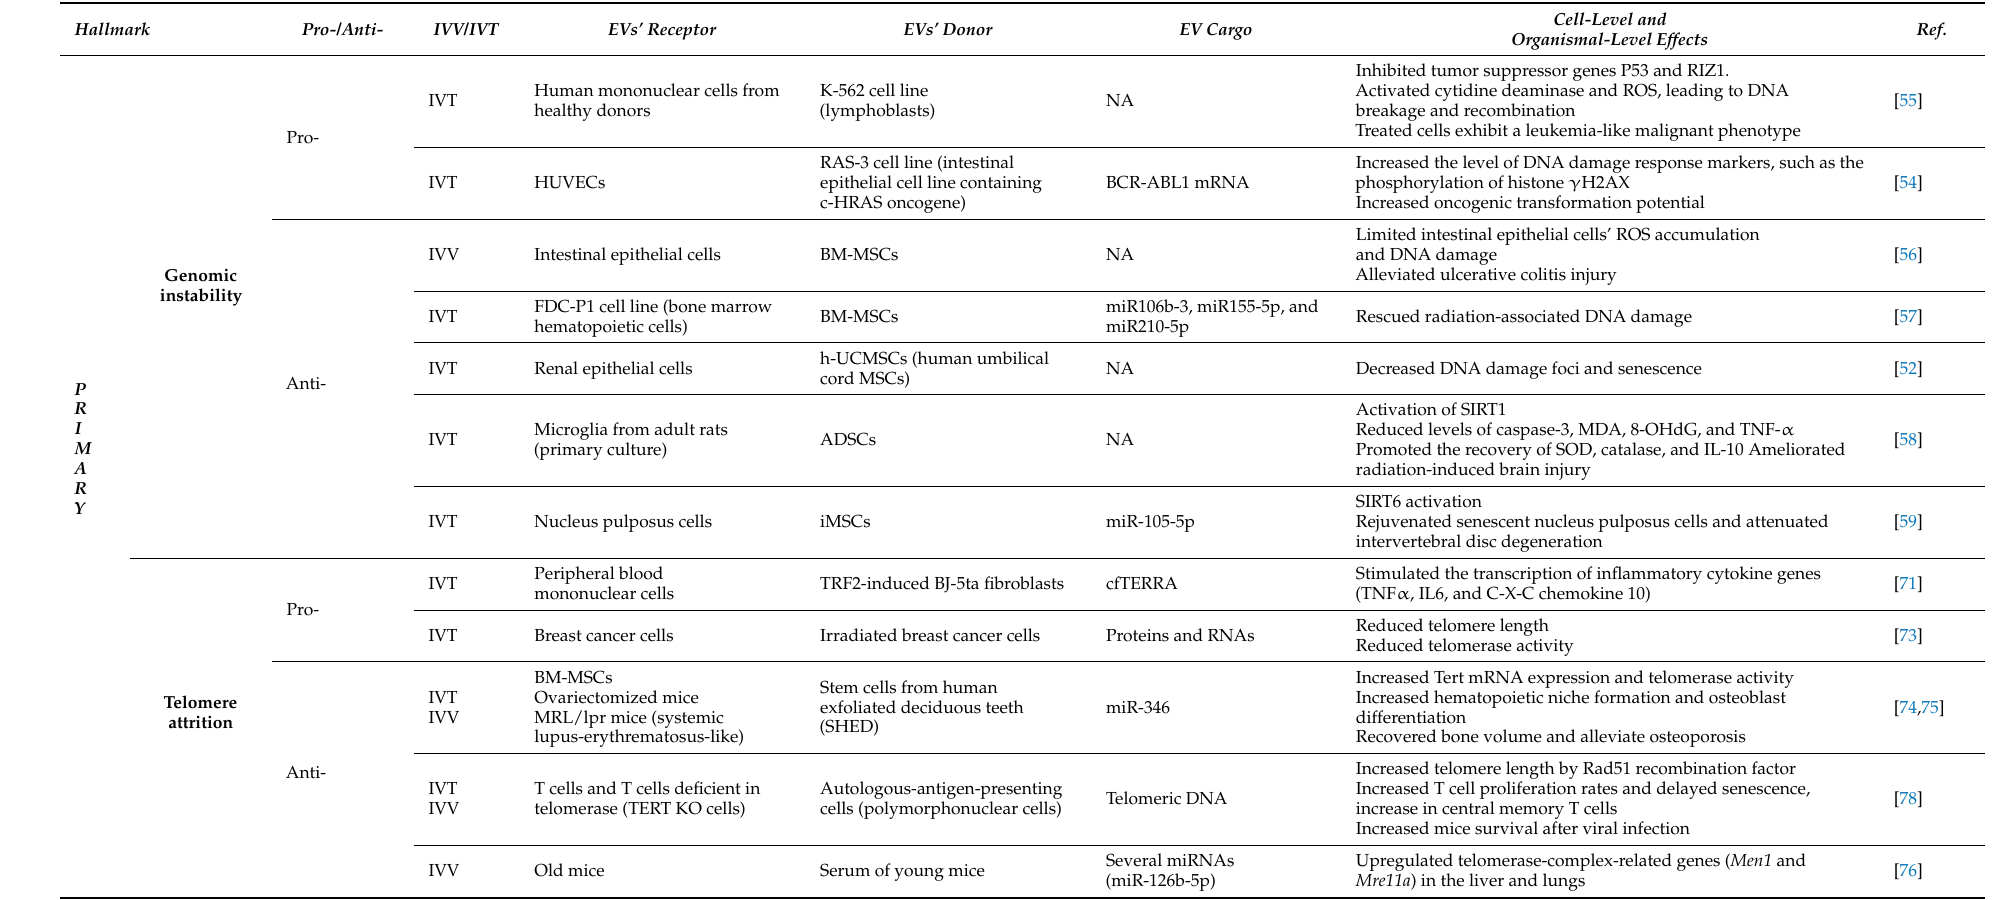
Table 1. Potential roles and effects of EVs on the hallmarks of aging. Pro-: pro-aging; anti-: anti-aging; IVT: in vitro; and IVV: in